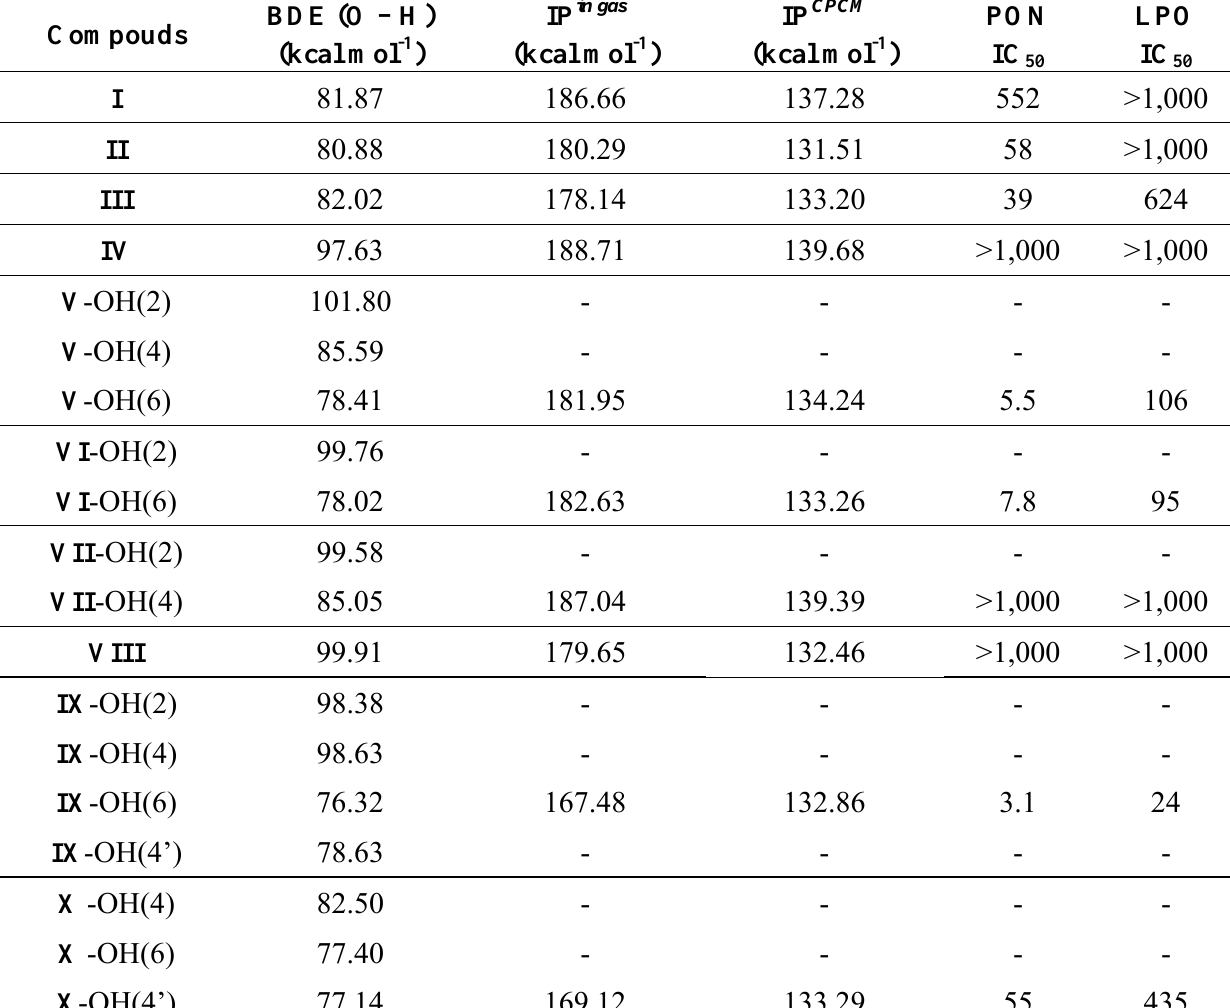
Table 2. IP and O-H BDE for dihydrochalcones and structurally